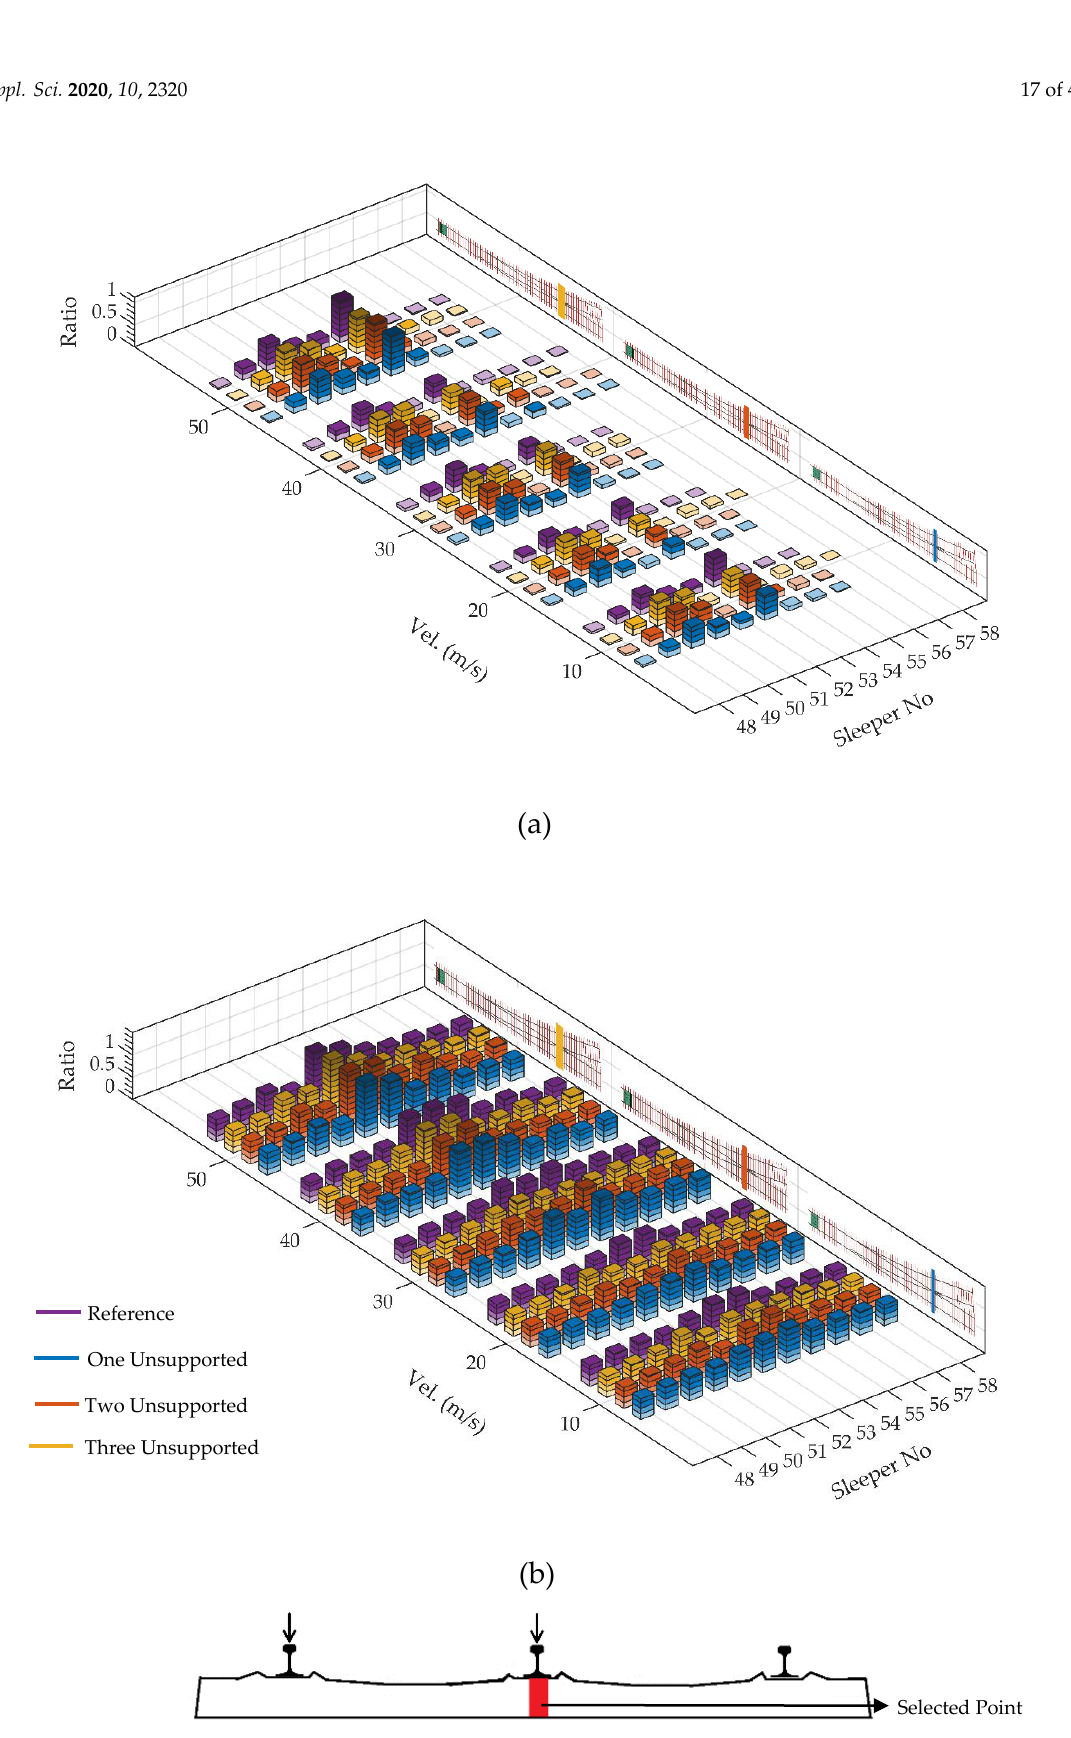
Figure 13. The distribution of rail seat force over the bearers when unsupported bearers exist under crossing nose: ( a ) at particular time when the front wheel is on the bearer with number 53; ( b ) when maximum occurs at each bearer.